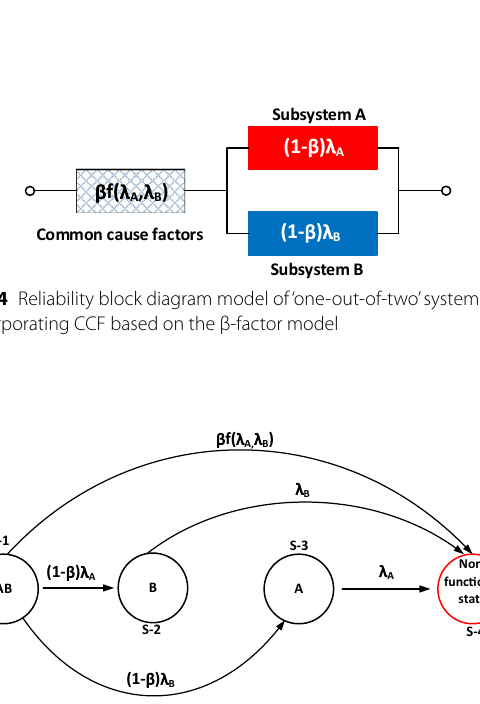
Fig. 5 Markov state transition diagram of ‘one-out-of-two’ system incorporating CCF based on the β factor